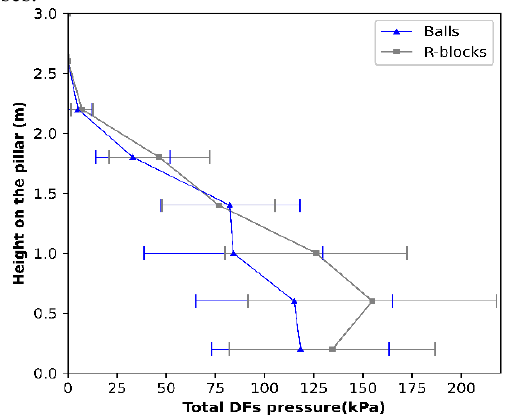
Fig. 7.: Total pressure applied by particles: balls and r-blocks on the pillar including horizontal bars showing time scattering.